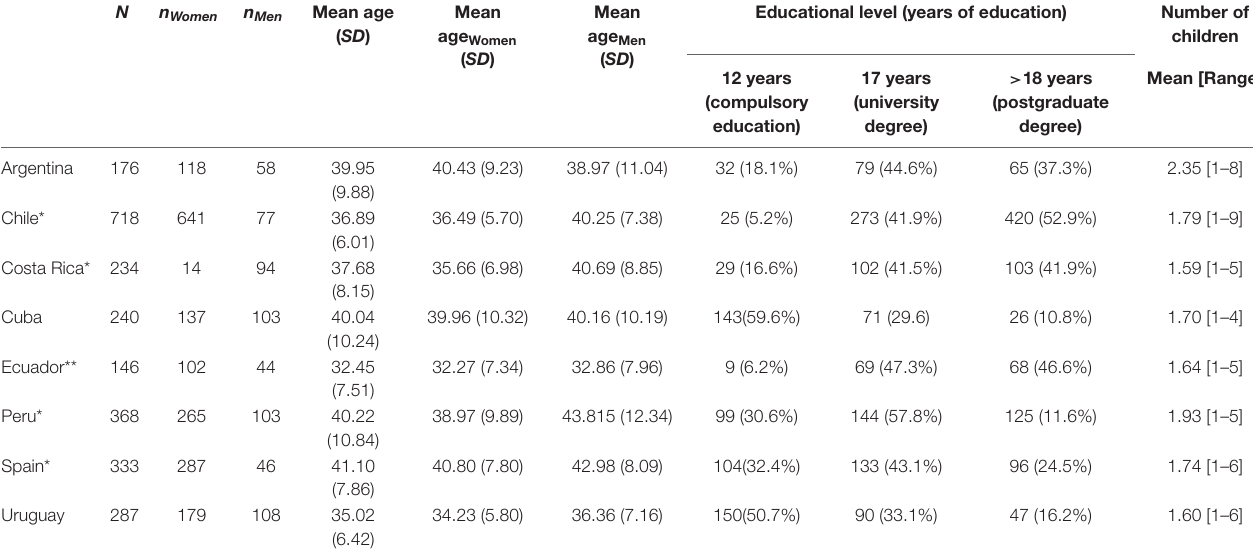
TABLE 1 | Demographic characteristics of the samples in Study 1.